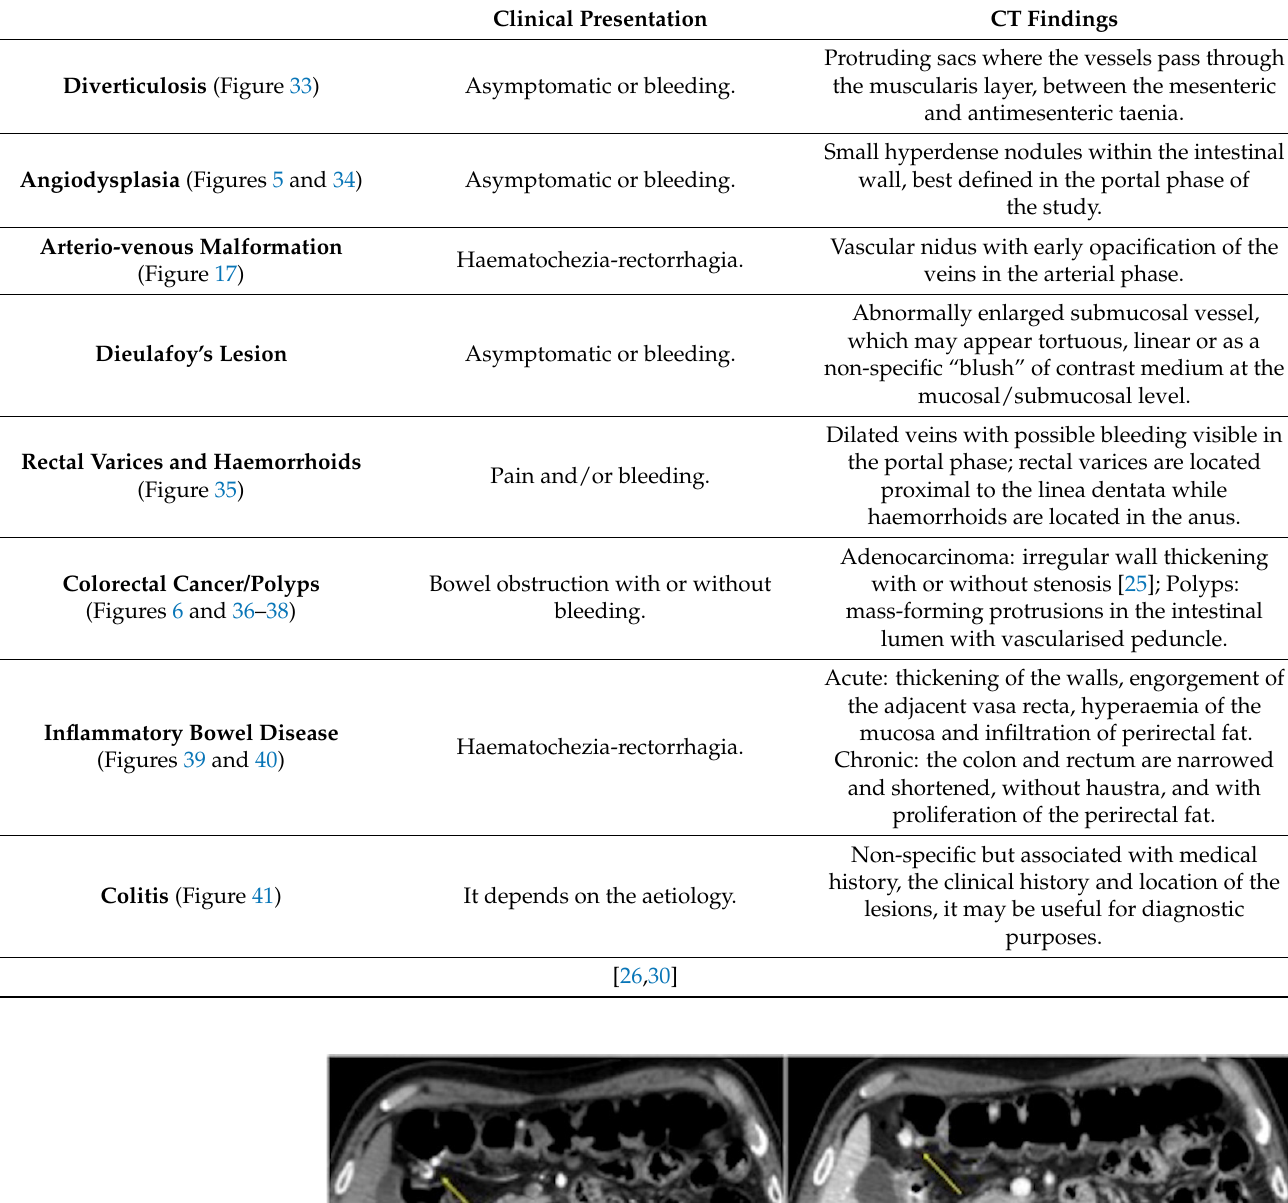
Table 7. Frequent vascular and non-vascular causes of LGIB: clinical presentation and CT findings.